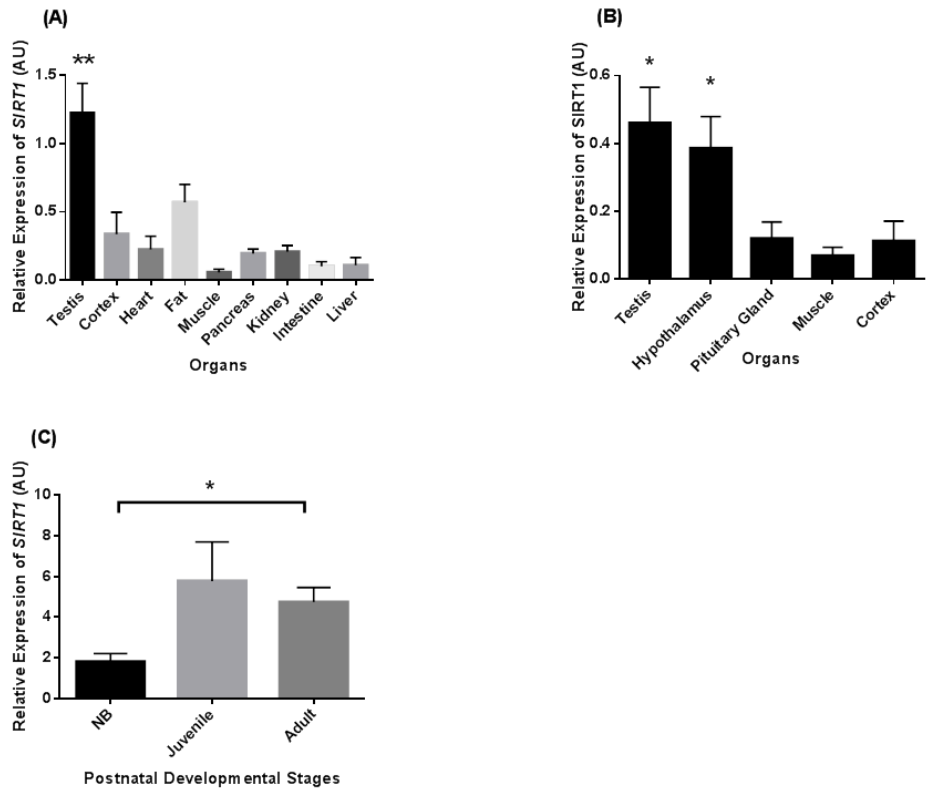
Figure 1. Sirtuin-1 ( SIRT1 ) relative transcript levels in different tissues and during postnatal (neonatal (up to 1 month), juvenile (5–6 months), and adult (3–5 years)) stages of the common marmoset monkey. ( A ) The transcript levels of SIRT1 is highest in testis as compared to other tissues. ( B ) SIRT1 mRNA was highest in testis and hypothalamus as compared to pituitary gland, muscle, and cortex tissues. ( C ) The expression level of SIRT1 mRNA was significantly higher in adult as compared to the neonatal stage. * p < 0.05, ** p < 0.01 significant increase.